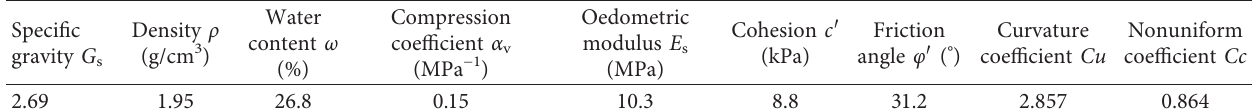
Figure 2: Particle size distribution curve of the foundation soil. Table 2: Basic physical and mechanical parameters of the foundation soil.